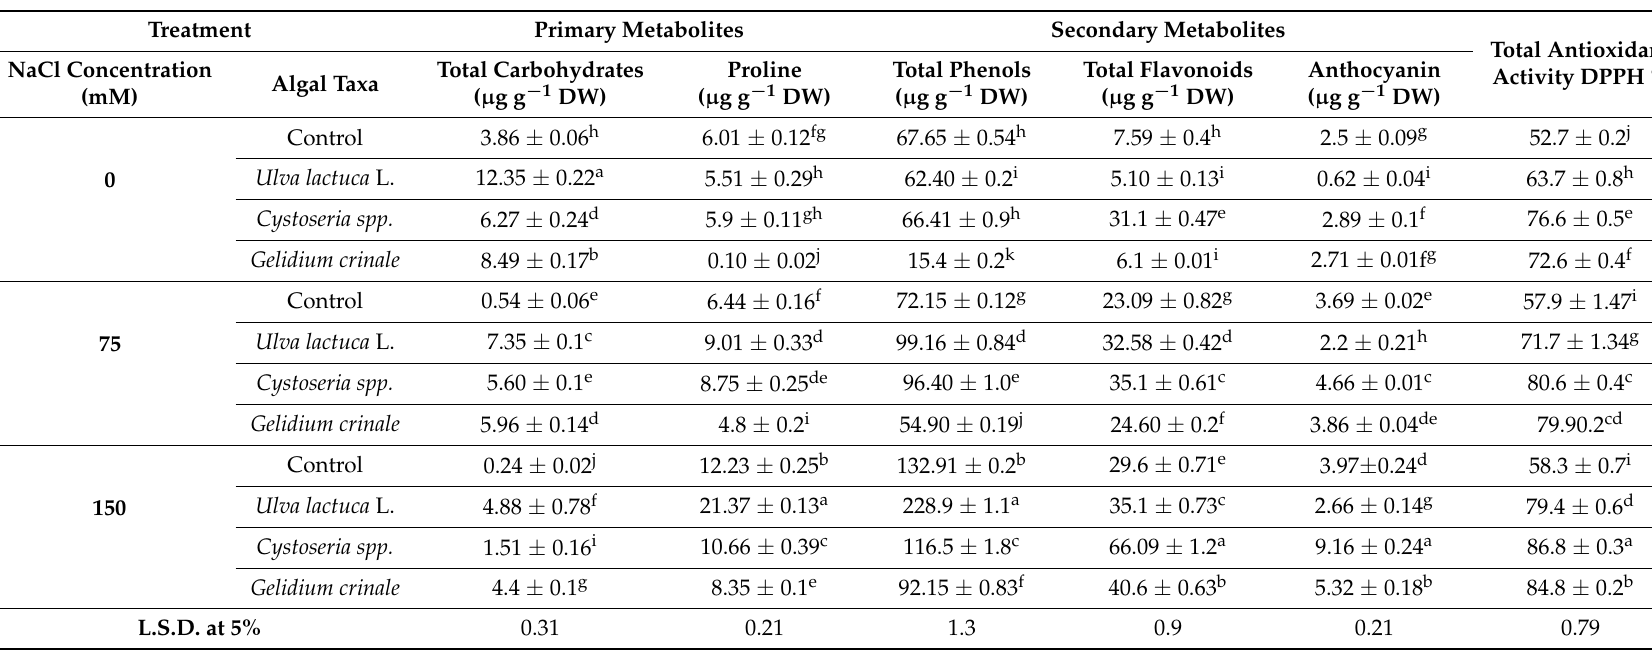
Different letters indicate significant differences based on a comparison of means with Duncan’s multiple range test at p <